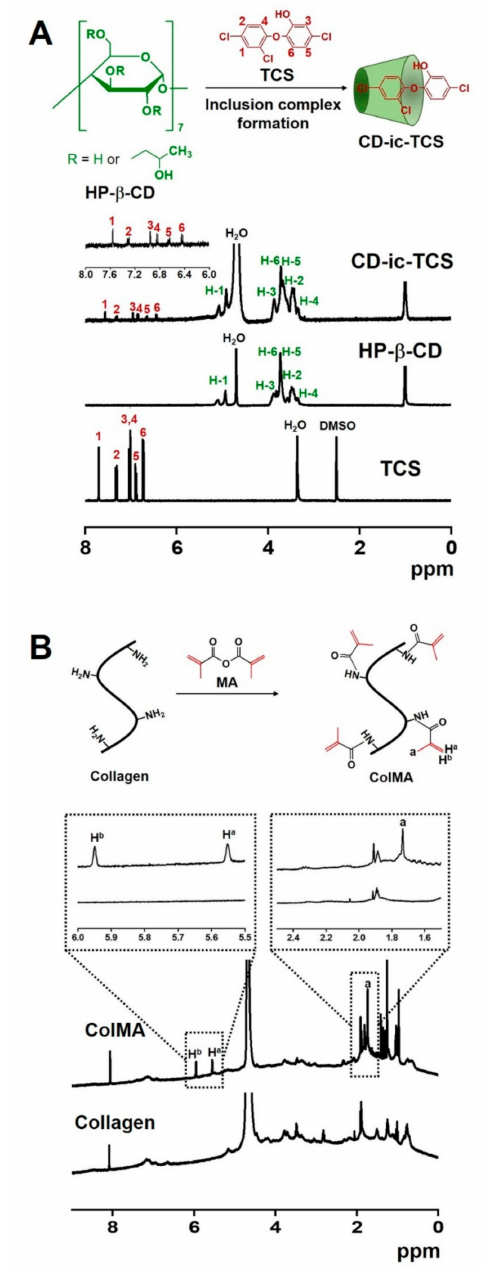
Figure 2. 1 H NMR spectra of ( A ) TCS, HP- β -CD, and CD-ic-TCS; and ( B ) collagen and ColMA. TCS was analyzed using DMSO- d6 . The 1 H NMR analyses of HP- β -CD and CD-ic-TCS were performed using D 2 O. Collagen and ColMA were analyzed using the co-solvents of D 2 O and acetic acid- d4